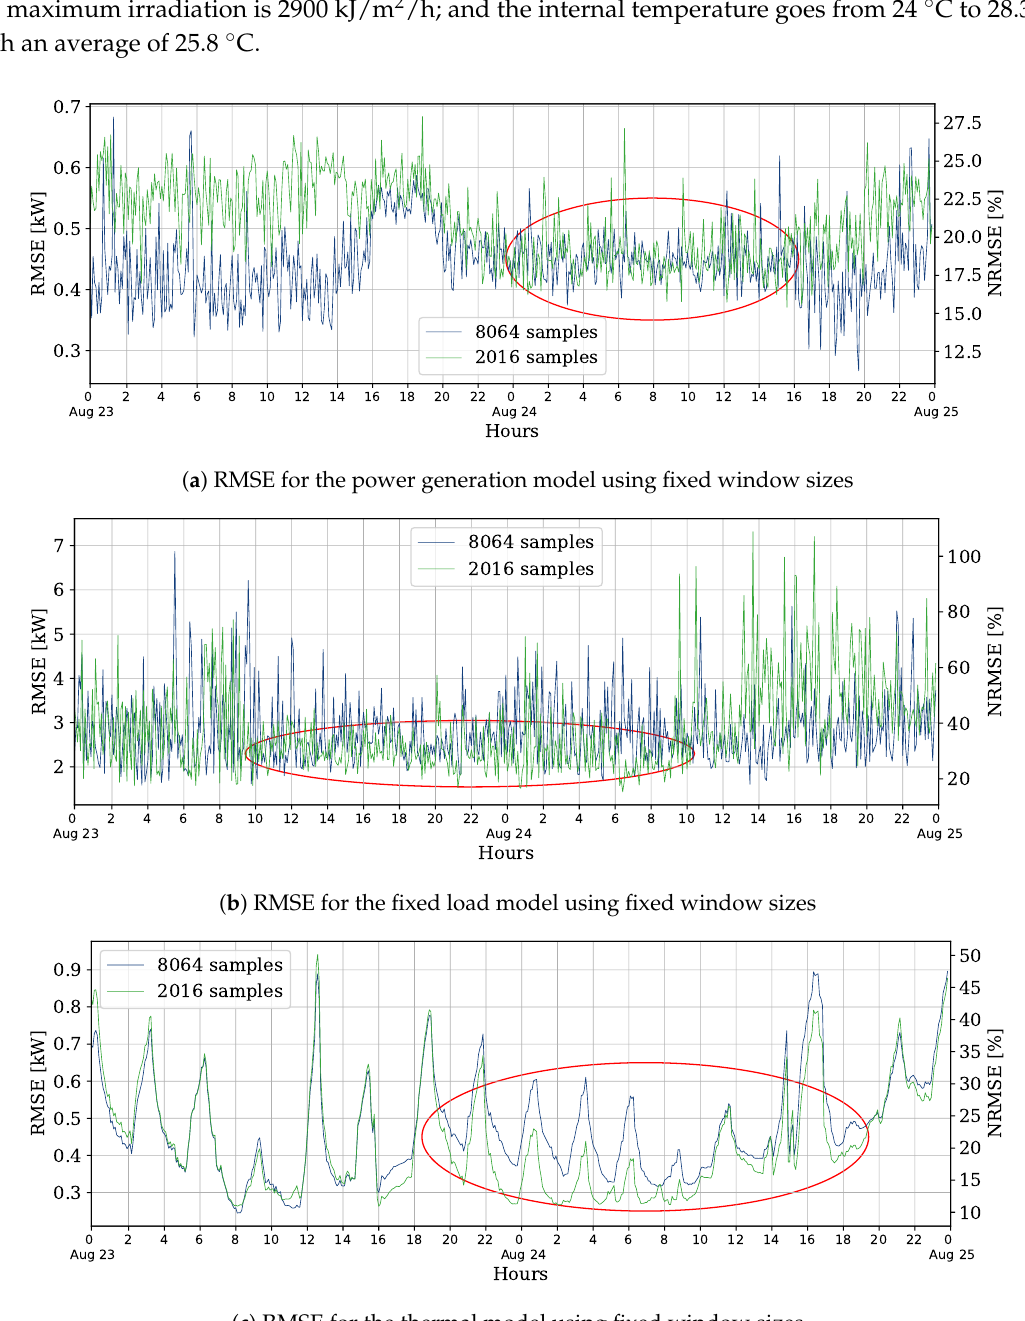
( c ) RMSE for the thermal model using fixed window sizes Figure 9. Identification of possible concept drifts in a summer